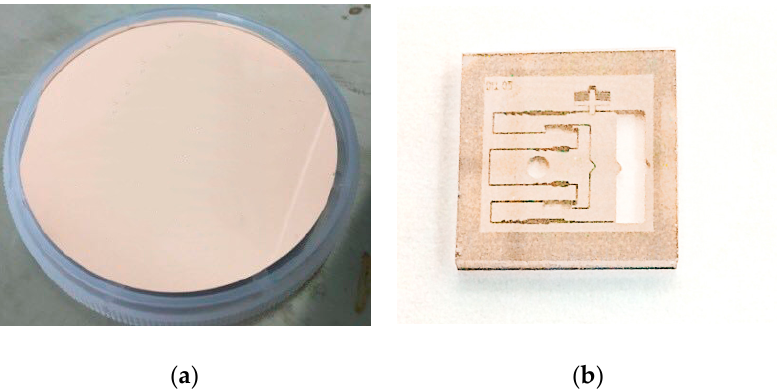
Figure 11. The MEMS S&A device after the Cu electroplating process. ( a ) Electroplated Cu wafer; ( b ) electroplated Cu graphics.